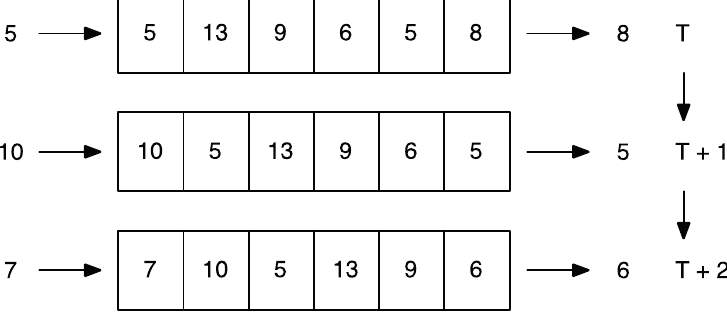
Figure 3. Queue data structure for time delay in a discrete simulation. Values that are produced, indicated on the left, are placed at the end of the queue structure. At each time step, values are shifted in the queue and the value at the front of the queue is removed. Progression of values is shown for two time steps, and the queue length represents a time delay of five time